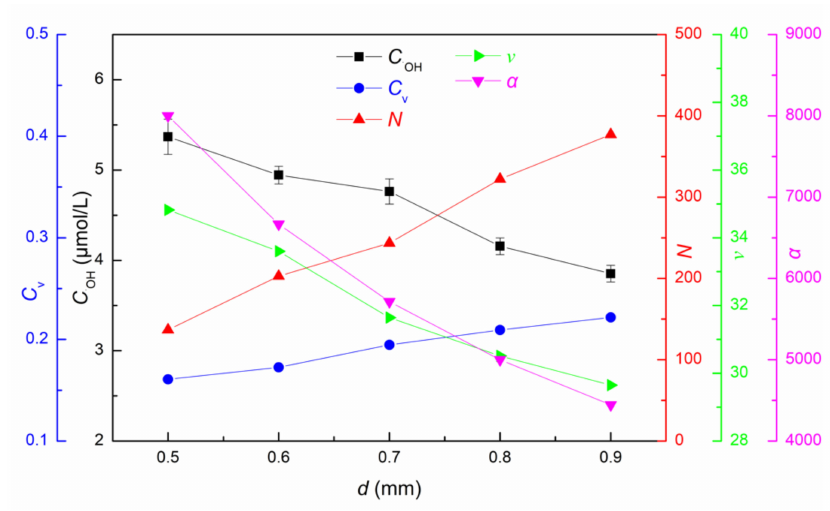
Figure 5. Influence of throat diameter on · OH yield, C v , N , v , and α values. (Conditions: P i = 0.4 MPa, T = 30 ◦ C, t = 50 min, V = 150 mL.).